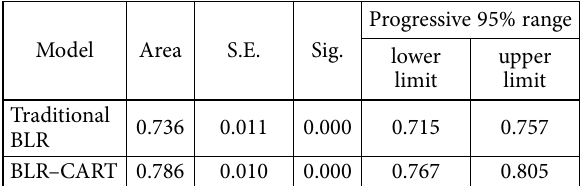
Table 6. ROC comparison between BLR–CART model